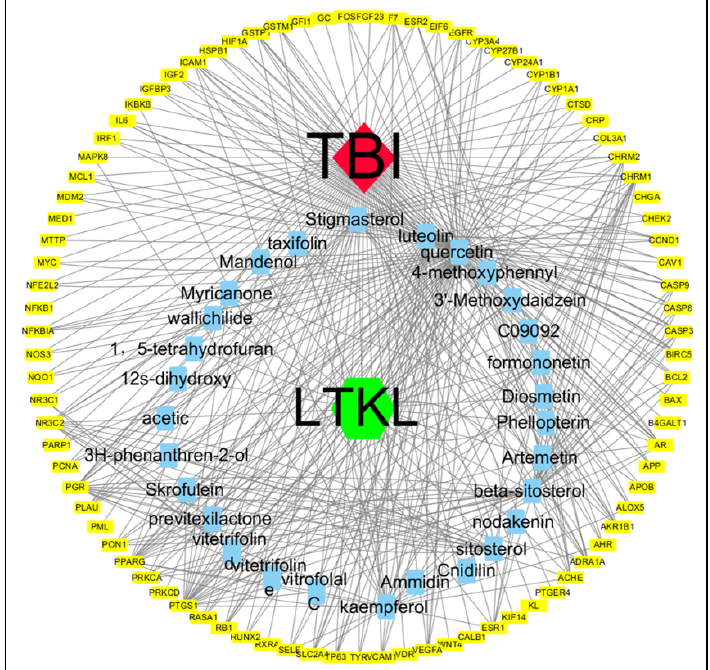
Figure 3 - Disease-formula-active compounds-target network for traumatic brain injury. The red, green, blue, and yellow nodes represent the disease, herbs, active compounds and targets, respectively. The edges represent the interactions among